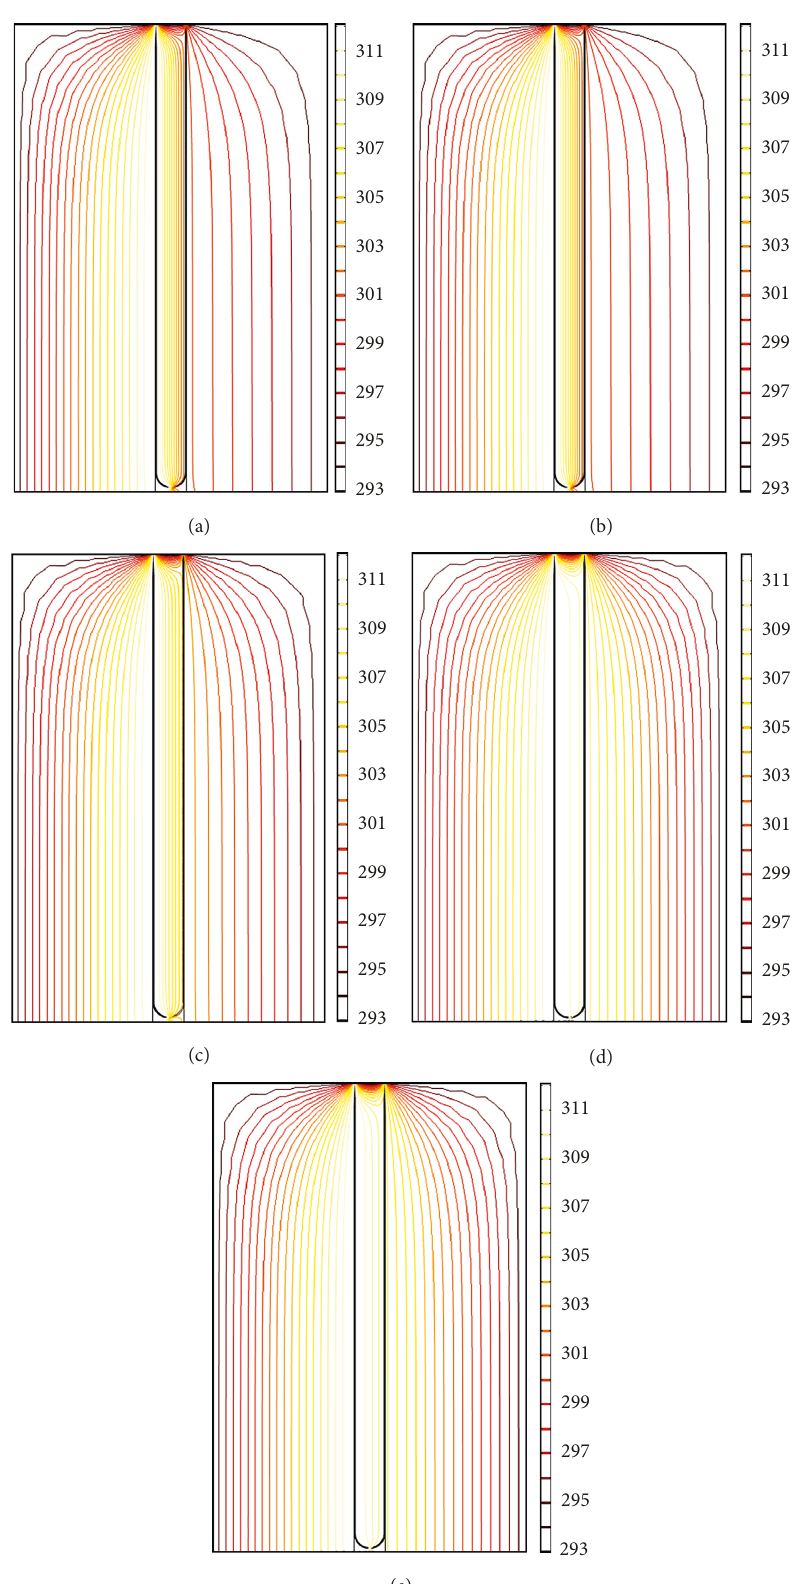
Figure 11: Predictedcontoursforheattransferinenergypileswithdifferentgraphitevolumetriccontents.(a)0%.